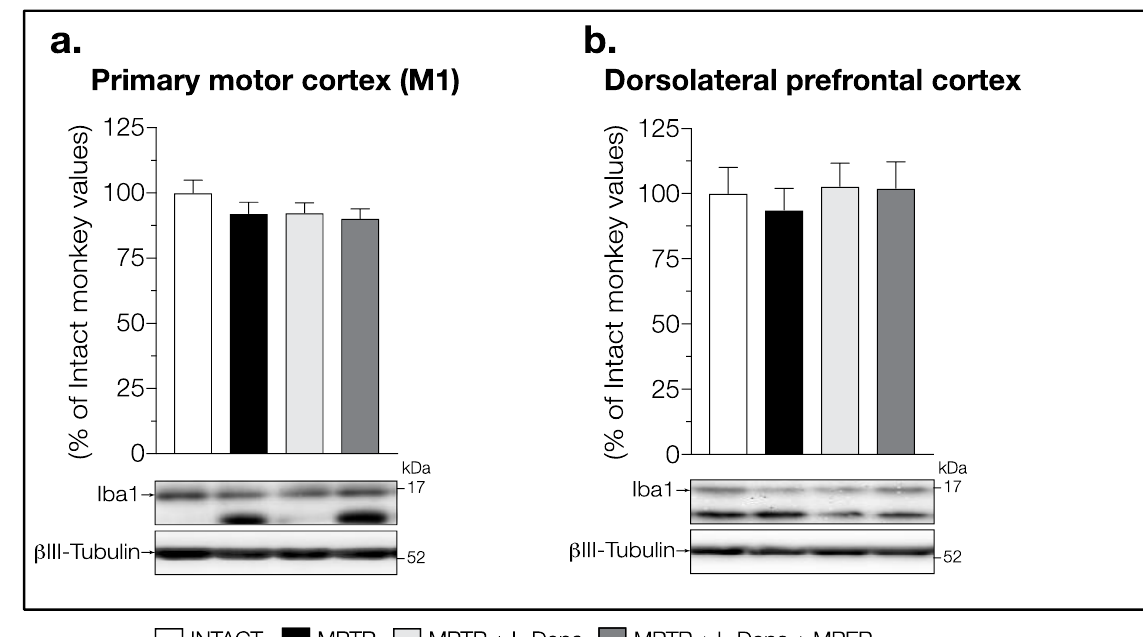
Figure 8. Western blots for Iba1 protein levels in ( a ) primary motor cortex (M1) and ( b ) dorsolateral prefrontal cortex (PFCd) of intact monkeys (control), MPTP monkeys treated with saline, L-Dopa, and L-Dopa + MPEP. Values are means of arbitrary units expressed as percentage of control ( β III-tubulin was used as internal loading control) of 4–5 independent experiments ± standard error of mean of 4–5 monkeys per group.